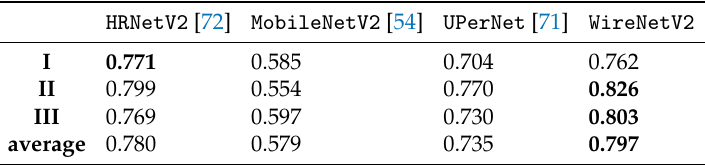
Figure 10. Examples of semantic segmentation using MobileNetV2 [54], UPerNet [71], HRNetV2 [72], and the WireNetV2 model on independent test split of the dataset to automatically separate wires and background. Note that most of the compared methods fails to distinguish between foremost and rare wire structures. Table 4. Intersection-over-Union (IoU) values for the WireNetV2 model and three state-of-the-art methods for various levels of the tower and the average IoU for all